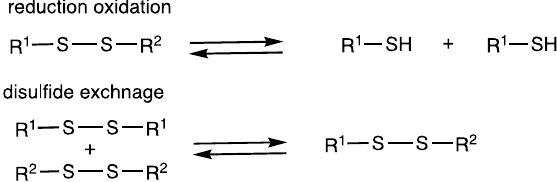
Figure 1. Interconversion reactions of disulfides / thiols by reduction / oxidation and chemical equilibrium under disulfide exchange.